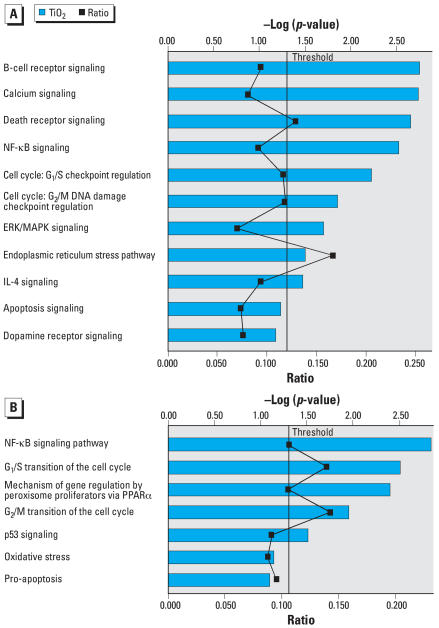
BV2 microglia were exposed to P25 (20 ppm) for 3 hr and prepared for microarray analysis. IL-4, interleukin 4; PPARα, peroxisome proliferator-activated receptor α (A) IPA’s Core analysis (metabolic/signaling pathways) indicated that up-regulated genes were clustered around signaling pathways involved with apoptosis, Death receptor families (i.e., caspase activation), calcium signaling, inflammation (NF-κB), and cell cycling and maintenance. (B) Toxicity Pathway analysis indicated that P25 up-regulated pathways were primarily associated with inflammatory (NF-κB), cell cycling and pro-apoptotic activities.